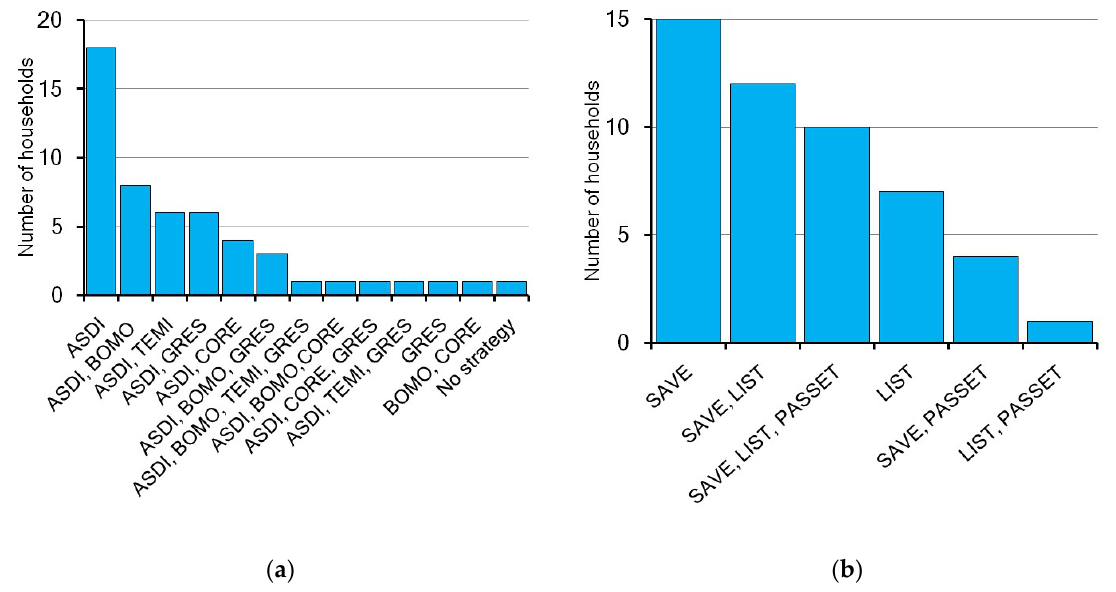
Figure 3. ( a ) Recovered from last flood and adopted ex-post coping strategies (n = 52). ( b ) Recovered from last flood and assets disposal category (n = 49). Note: BOMO: Borrowing money; ASDI: Assets disposal; CORE: Consumption reduction; TEMI: Temporary migration; GRES: Grants from external sources; SAVE: Disposal of previous savings; LIST: Sold livestock; PASSET: Sold productive assets (Source: Field Survey, 2019).